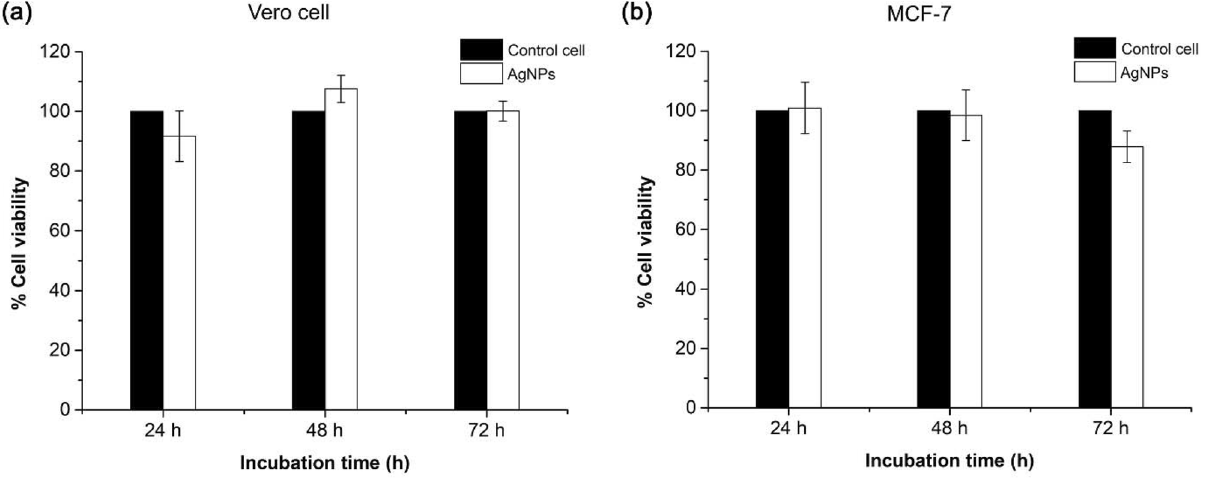
Figure 2. Cytotoxicity of andro-AgNPs towards normal (Vero cell) and cancerous (MCF-7) mammalian cell lines, evaluated by MTT assay. Vero cell and MFC-7 were incubated with andro-AgNPs at 100 µg/mL for 24, 48, and 72 h. The same cells without andro-AgNPs were monitored as a control for 100% viability. The data represent mean value ± SD (error bar) from two independent experiments carried out in triplicate ( n = 6).